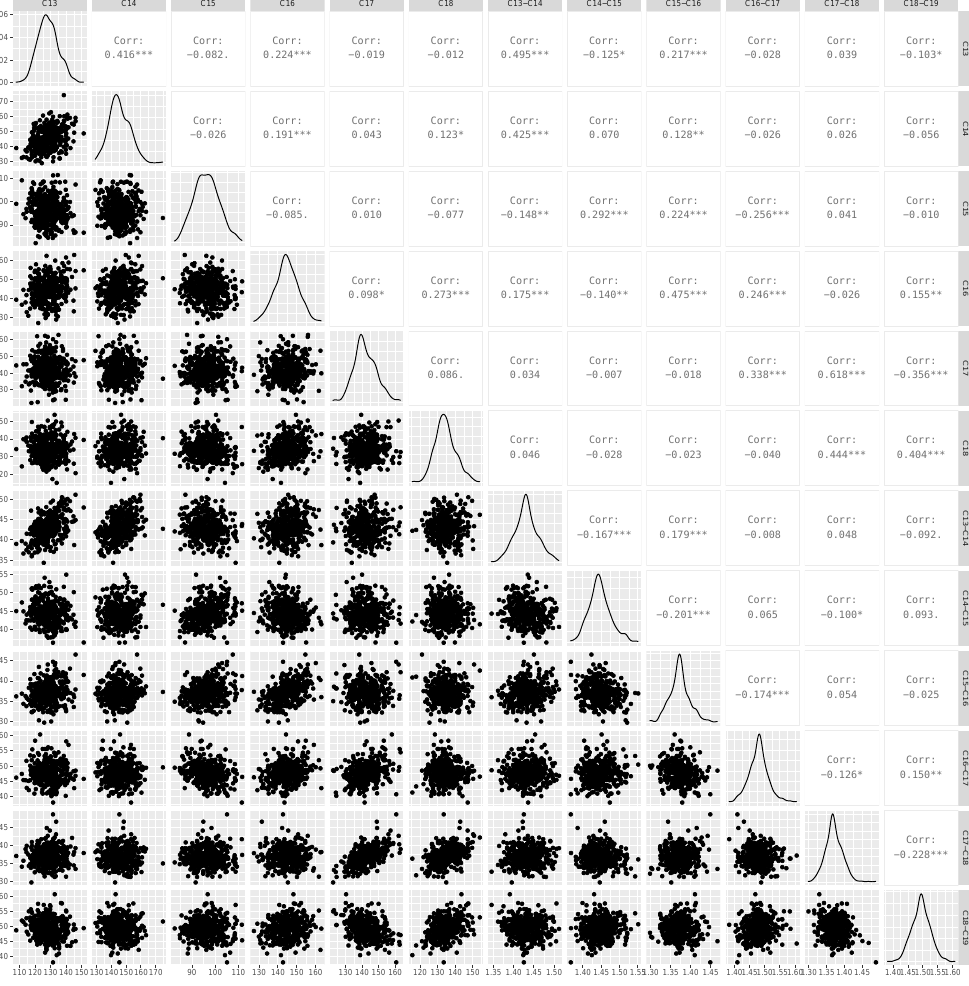
Figure A2. Explicit correlation plot of C-C bond lengths and 13 C chemical shifts in